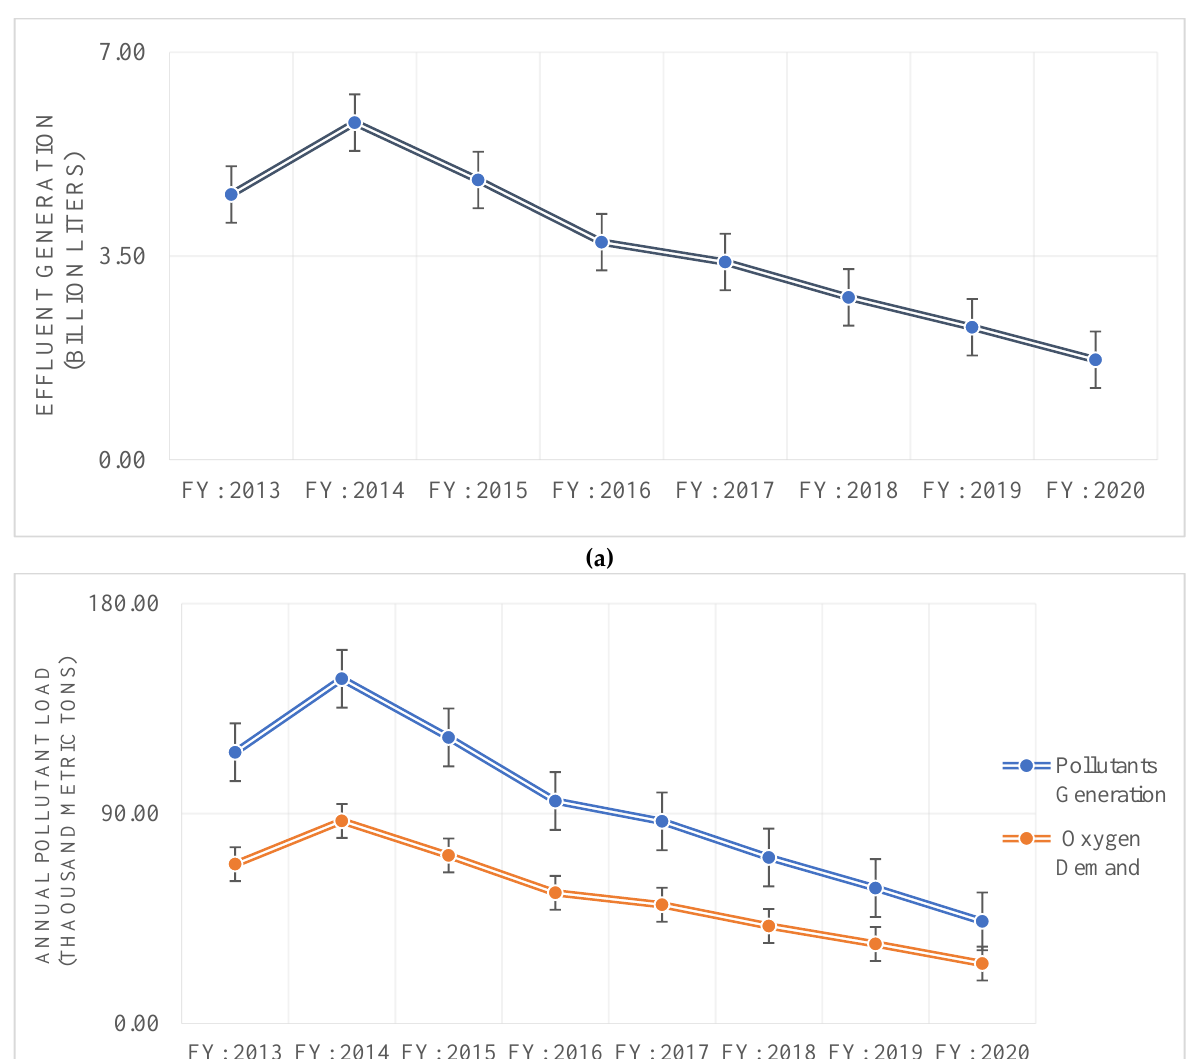
Figure 5. Effluent and pollutant generated by leather processing factories in Bangladesh from FY 2013 to FY 2020: ( a ) effluent generation, ( b ) pollutant generation and oxygen demand from leather processing factories.